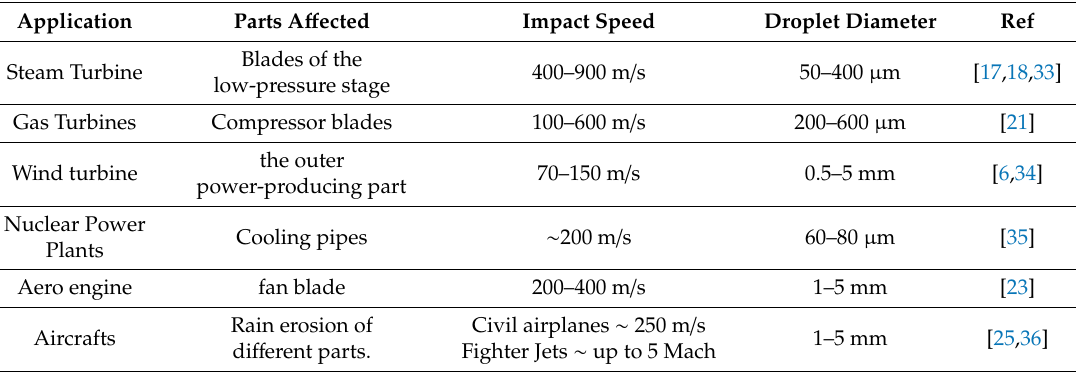
Table 1. Summary of the erosion conditions in some applications.